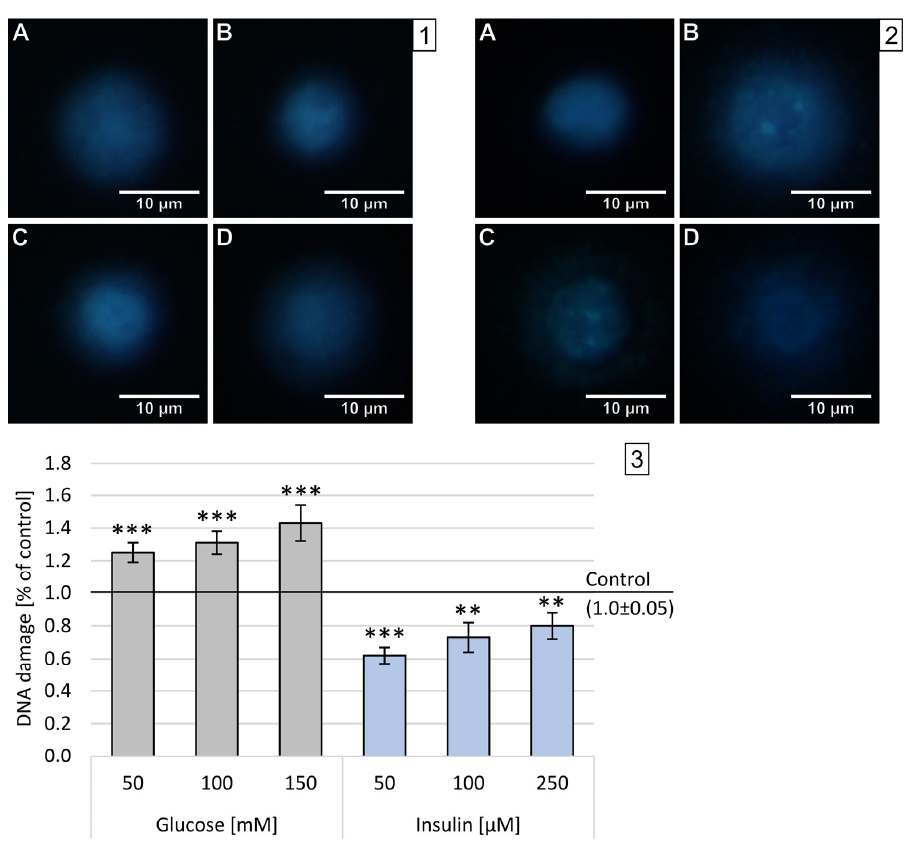
Figure 5. Analysis of double-stranded DNA breaks in neuron-like cells after 24 h incubation with glucose or insulin. ( 1 ) Sample microphotographs of a nuclear diffusion halo: A—control (untreated cells), B—glucose 50 mM, C—glucose 100 mM and D—glucose 150 mM. ( 2 ) Sample micro-